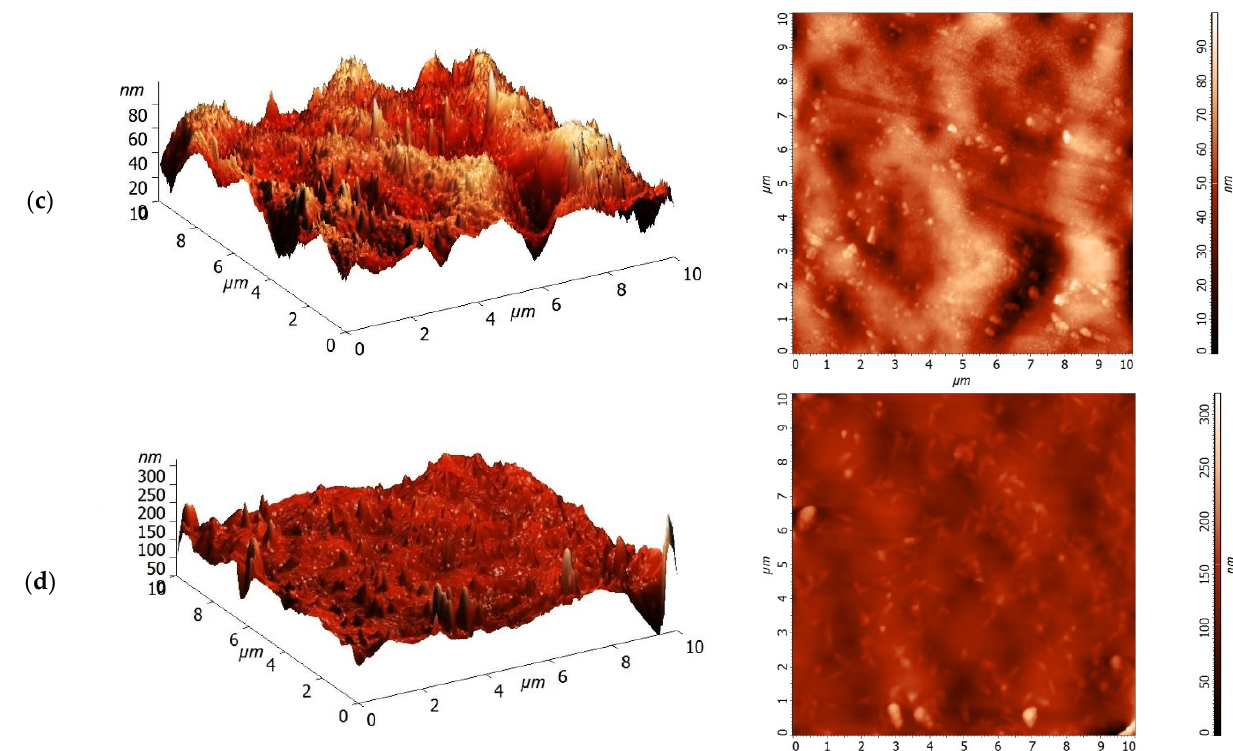
Figure 6. AFM images of the membranes based on PA ( a ) and PA/TiO 2 (0.3 ( b ), 0.5 ( c ), and 0.75 ( d ) wt.%) composites.